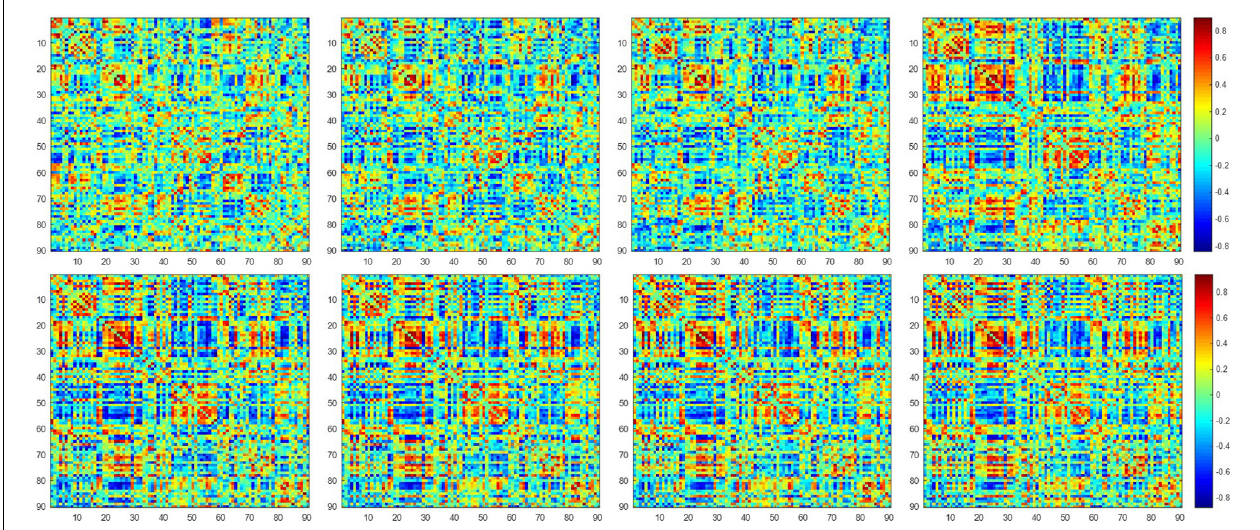
FIGURE 2 | The constructed low-order FC networks. Each sub-figure corresponds to a different dynamic sliding window. Each element in the matrix is the correlation between two brain regions through the pairwise Pearson’s correlation analysis. Element with light color indicates positive correlation, while the dark color shows a competitive or anti-correlation relationship between